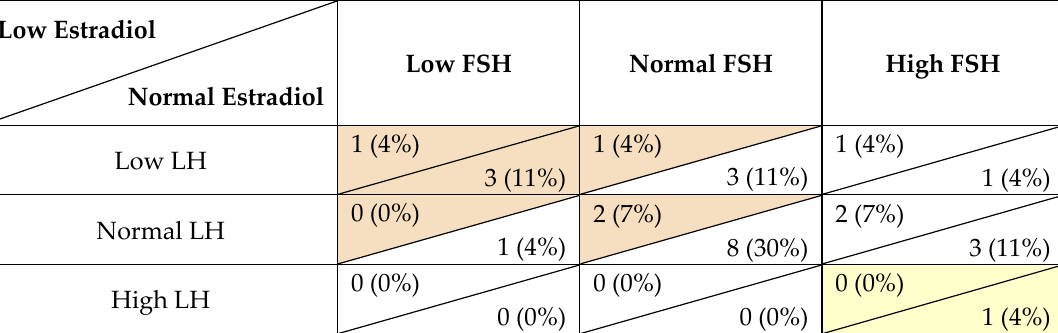
Table 3. LH, FSH and estradiol values in 27 women with Prader-Willi syndrome and hypogonadism. Low